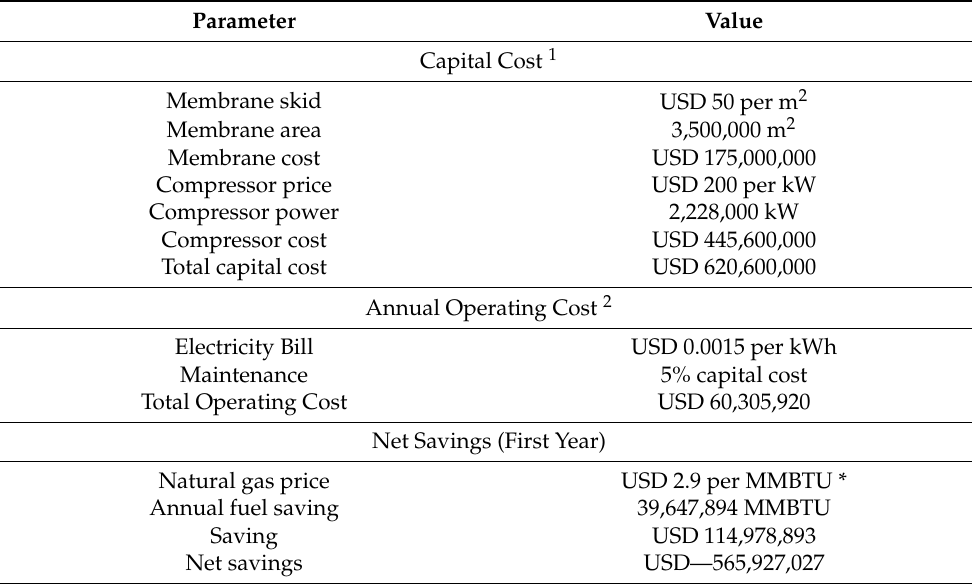
Table 5. Economic analysis to produce 30 mol% oxygen for the Alzour power plant [6,23]. Parameter Value Capital Cost 1 Membrane